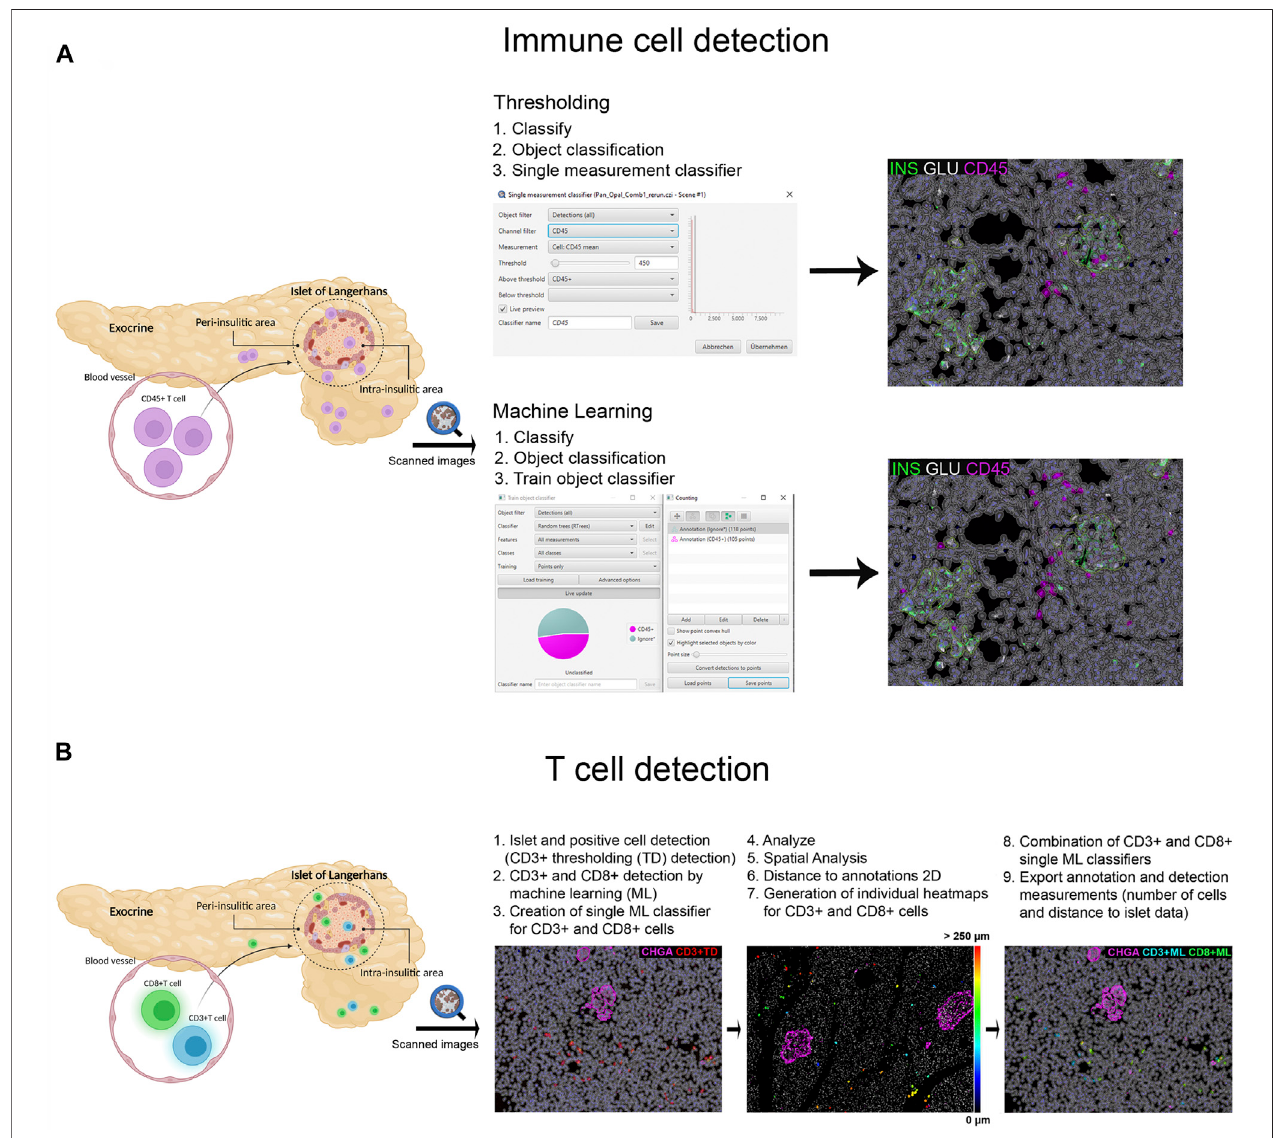
FIGURE2| Schematic illustration oftheimmunecell detection work fl owusing QuPath. (A) Comparison ofthethresholding (singlemeasurementclassi fi er) and the machine learning (train object classi fi er) option for the detection of CD45+ cells. (B) Work fl ow for the detection and distance analysis of CD3+ and CD8+ cells detected with thresholding and machine learning. Heatmaps were created to depict the relative distance of CD3+ and CD8+ cells (either individually or combined as one class) to the annotated islets.